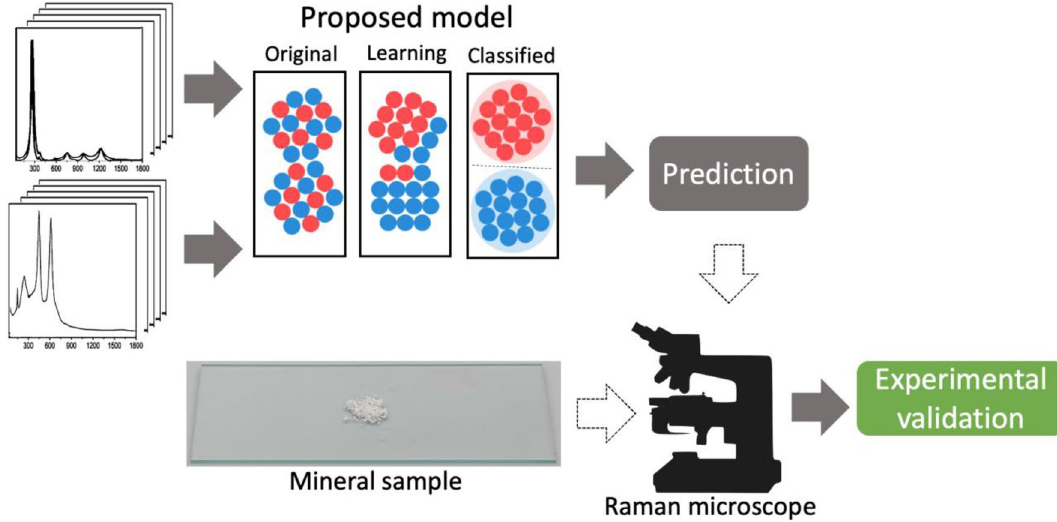
Figure 1. Schematic overview of the process